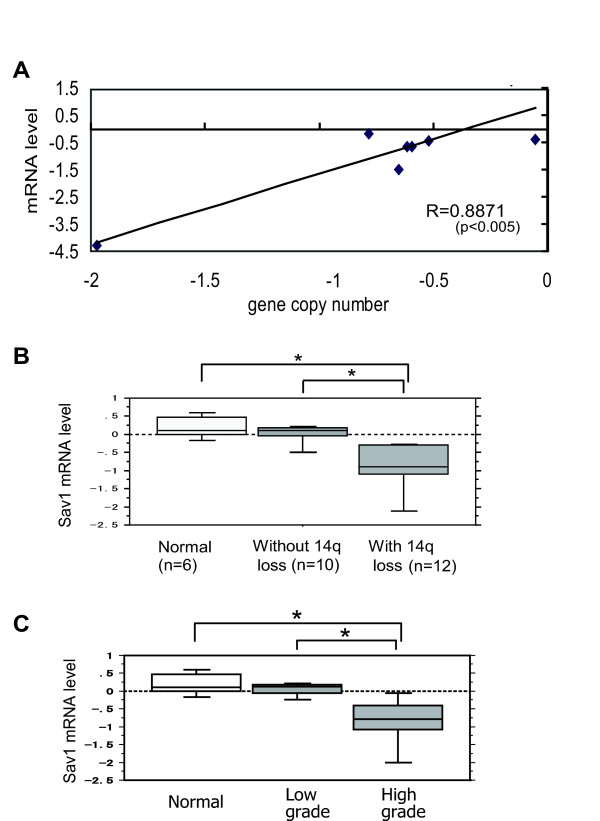
SAV1 is downregulated in RCC with copy number loss at 14q22.1. a Positive correlation of copy number with the expression ratio (R = 0.8871) of the SAV1 gene in RCC cell lines (786-O, 769-P, KMRC-1, KMRC-2, KMRC-3, KMRC-20, TUHR4TKB, and Caki-2). Log2 ratio of the normalized relative signal intensity of SAV1 by microarray (Y-axis) and log2 ratio of the gene copy number (X-axis) are plotted for each cell line. R, Pearson correlation coefficient. p-values were calculated by t test. b Correlation of the expression level with copy number loss of SAV1 mRNA at 14q. Quantitative RT-PCR was performed for ccRCC cases that had been analyzed by array CGH in our previous study [7]. On the basis of gene copy number ratio, ccRCC cases were divided into two groups [cases without 14q loss; log2 ratio -0.14 to 0.15 (n = 10), and cases with 14q loss; log2 ratio < -0.14 (n = 12)] and analyzed for their expression of SAV1. The box plots show the log2 ratio of SAV1 mRNA normalized by the median value for 6 samples of normal kidney (Normal). SAV1 mRNA levels are significantly lower in cases with 14q loss than in those without, and normal kidney (p < 0.005). The Y-axis displays the expression level (log2). P values were calculated by the Mann-Whitney U-test. *p < 0.005. Vertical lines in each column indicate mean ratio, and bars show s.d.. c Correlation of the expression level of SAV1 mRNA with tumor grade. The box plots show log2 ratio of SAV1 mRNA normalized by the median value for 6 samples of normal kidney. SAV1 mRNA levels are significantly lower in high-grade ccRCC tissue than in low-grade ccRCC and normal kidney (p < 0.005).